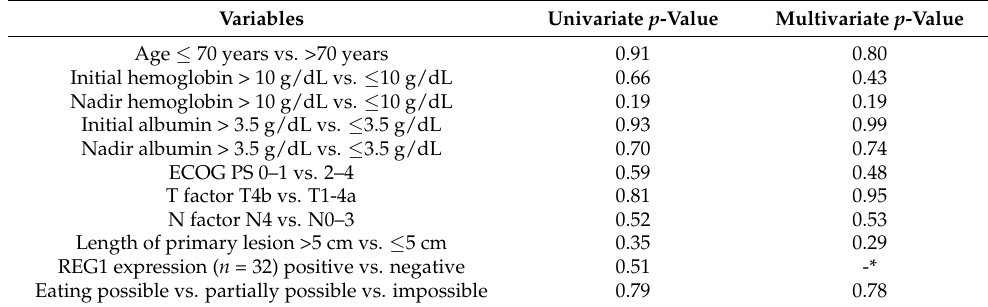
Table 5. Univariate and multivariate analyses of factors that are associated with progression-free survival.